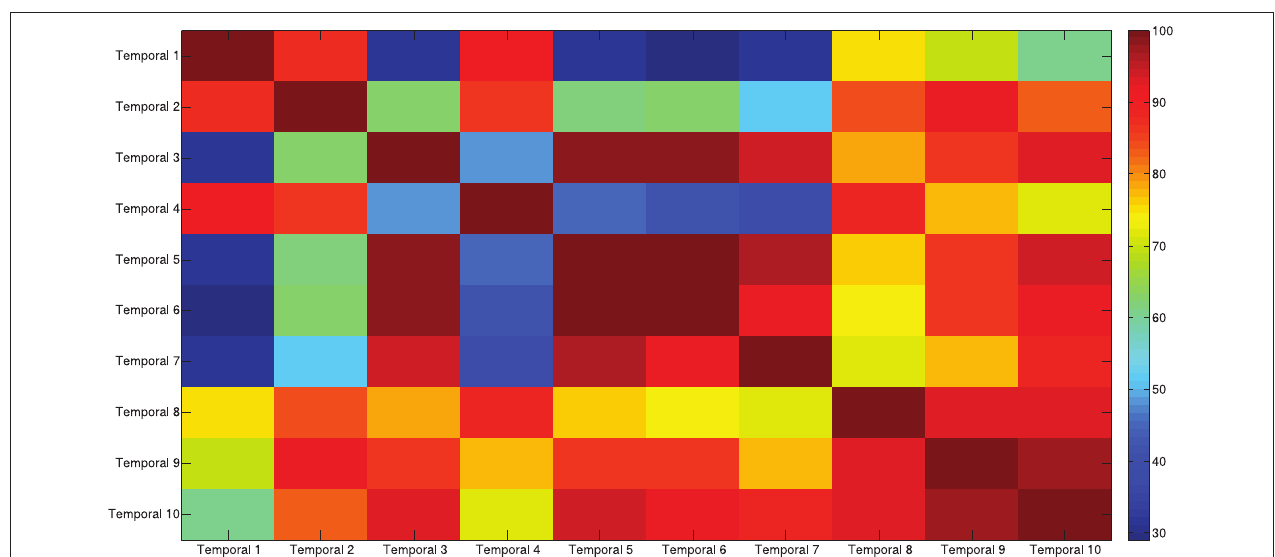
FIGURE 9 | Temporal components correlation matrix. The matrix identifies the variability between all the pairs of temporal components associated to the mean spatial synergies, assessed with the Pearson’s Correlation coefficient. The paired correlation ranges from 0.30 to 1, indicating that some modules are exploited with very similar (shared) control signals, while other modules are controlled with different